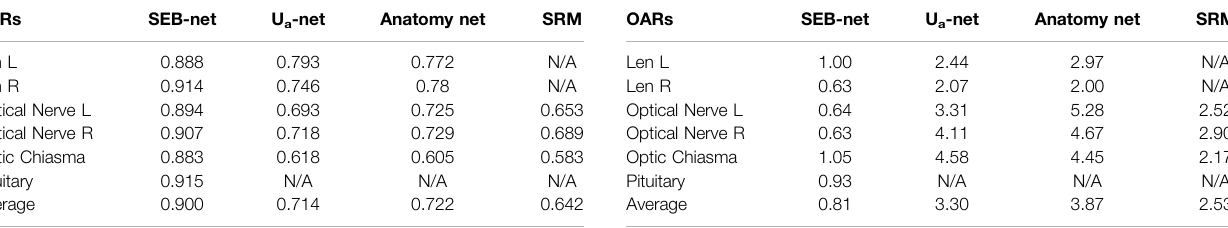
TABLE 3 | Average DSC comparison for small organs on the test. OARs SEB-net